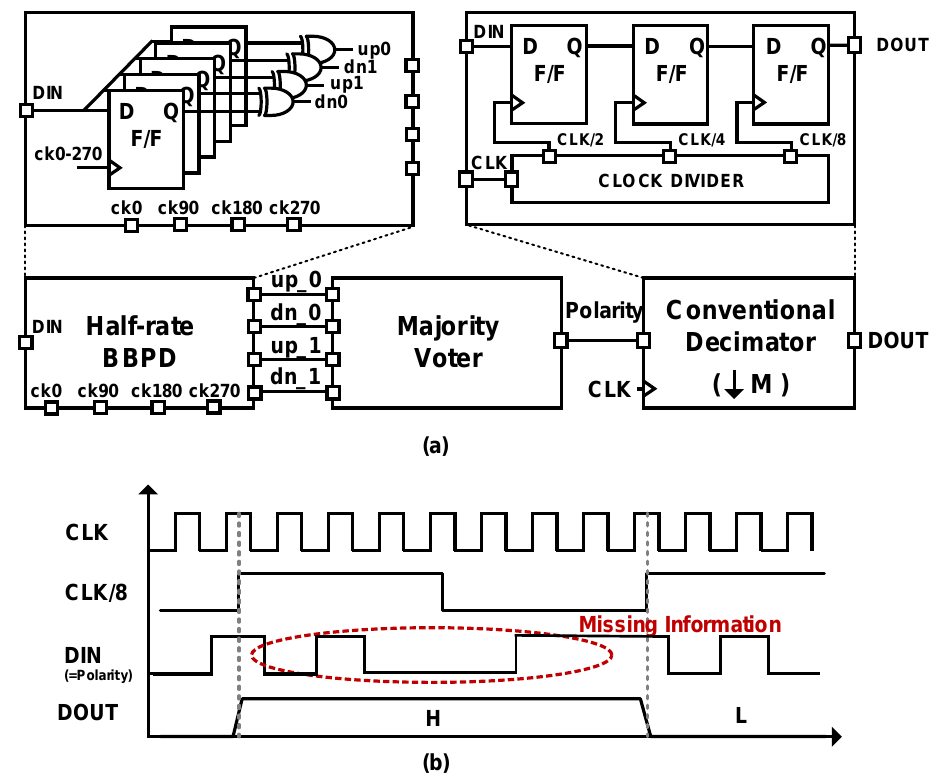
Figure 7. ( a ) Conventional decimator scheme with BBPD, ( b ) The operation behaviors of the conven- tional